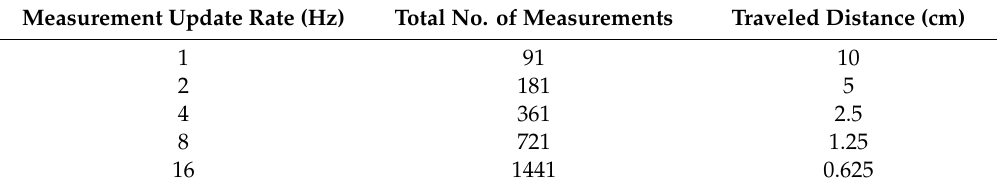
Table 1. The total number of measurements obtained along the three-dimensional (3D) linear path at all investigated measurement update rates, and the corresponding traveled